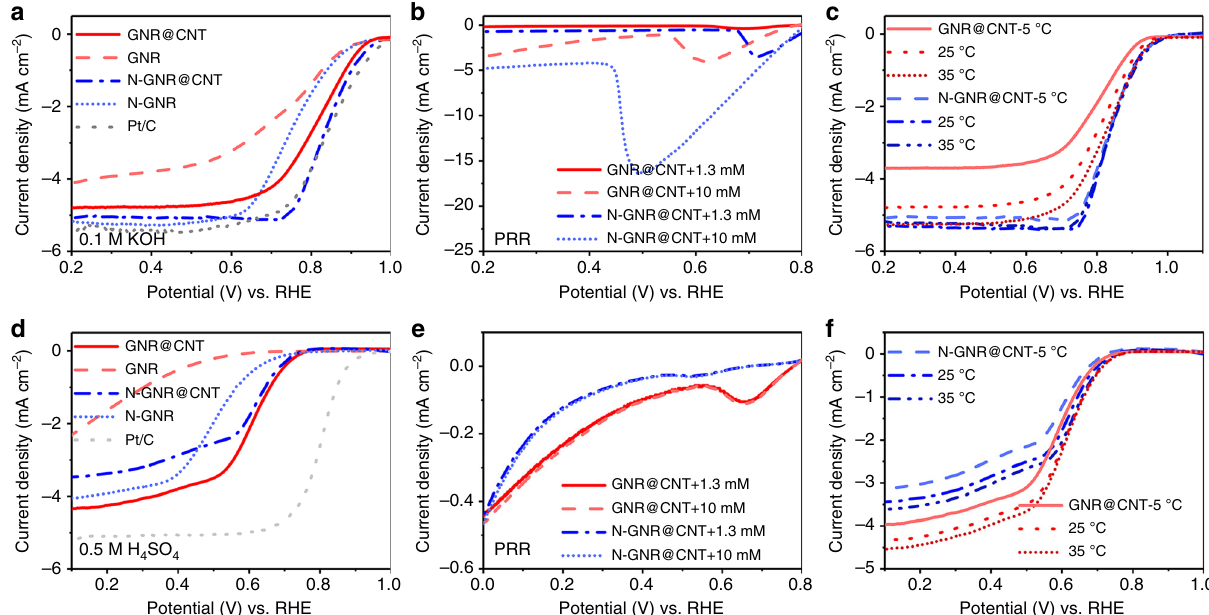
Fig. 3 Half-cell characterization of the catalysts. Linear sweep voltammetry curves of graphene nanoribbons on carbon nanotubes (GNR@CNT), N-doped GNR@CNT (N-GNR@CNT), and N-doped graphene nanoribbons (N-GNR) for a oxygen reduction reaction (ORR) activity, b peroxide reduction reaction (PRR) activity with 1.3 or 10 mM H 2 O 2 , and c ORR activity at 5, 25, and 35 °C in 0.1 M KOH; d ORR activity, e PRR activity with 1.3 or 10 mM H 2 O 2 , and f ORR activity at 5, 25, and 35 °C in 0.5 M H 2 SO 4 . Electrolyte was O 2 -saturated, except for PRR experiments with Ar-saturated electrolyte. Rotating